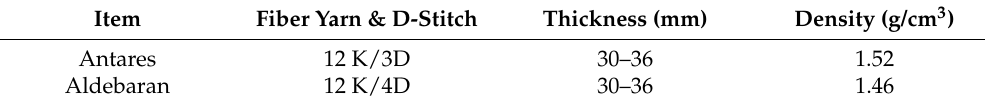
Table 2. Main characteristics of the two manufactured C/C prototypes.